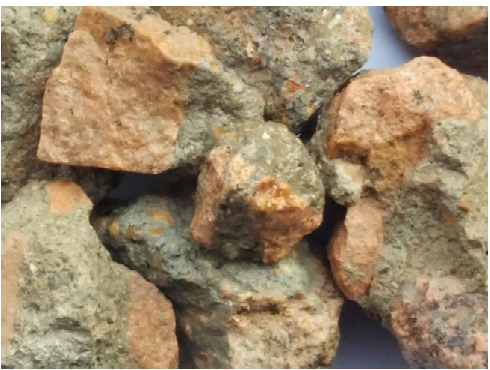
Figure 3. Appearance of the recycled coarse aggregate and attached mortar.